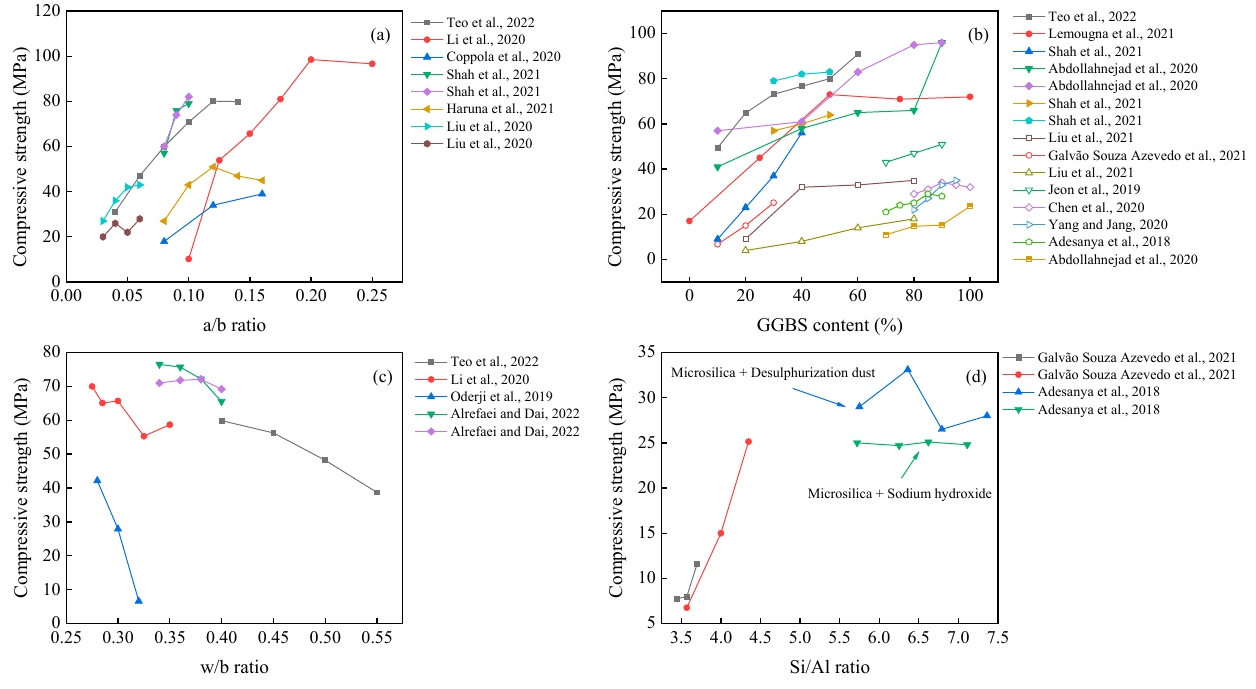
Figure 8. Effects of a/b ratio ( a ); GGBS content ( b ); w/b ratio ( c ); Si/Al ratio ( d ) on compressive strength of one-part AAM. [42,44,54,59,61,64,67,68,79,83,87,90,91,93,95,108]